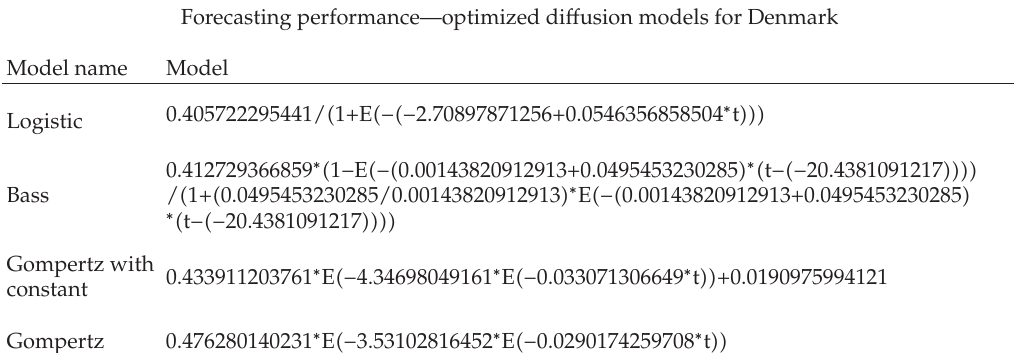
Table 36: Representation of the optimized di ff usion models in forecasting (cid:2) Denmark (cid:3) . Forecasting performance—optimized di ff usion models for